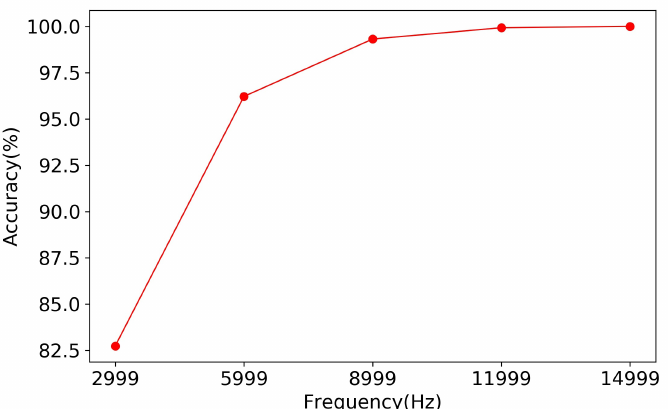
Figure 4. Accuracy of CacheHawkeye .